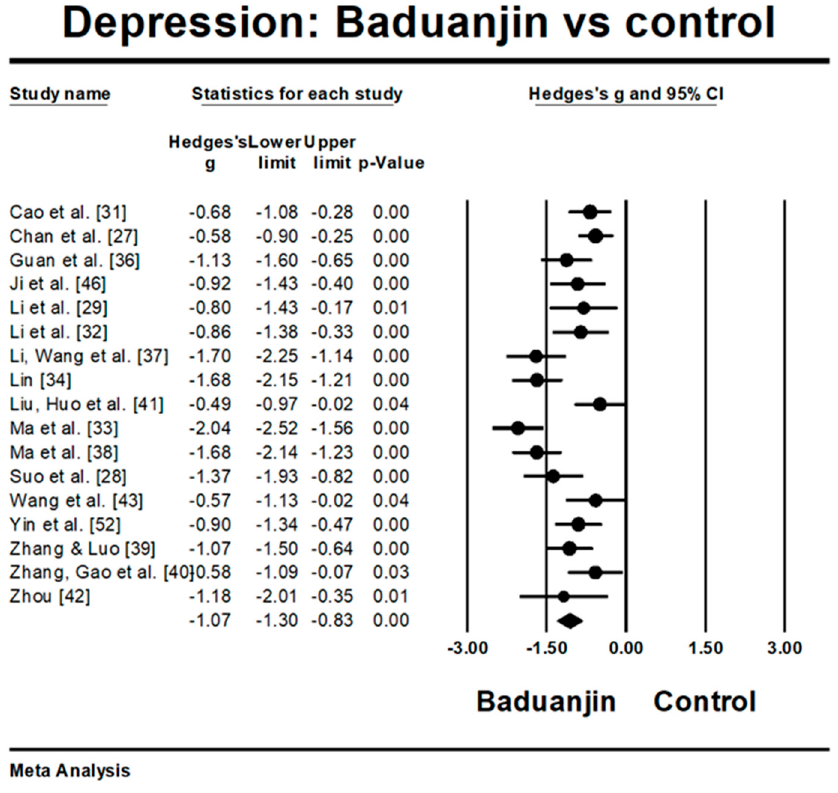
Figure 3. Effect of Baduanjin on depression.